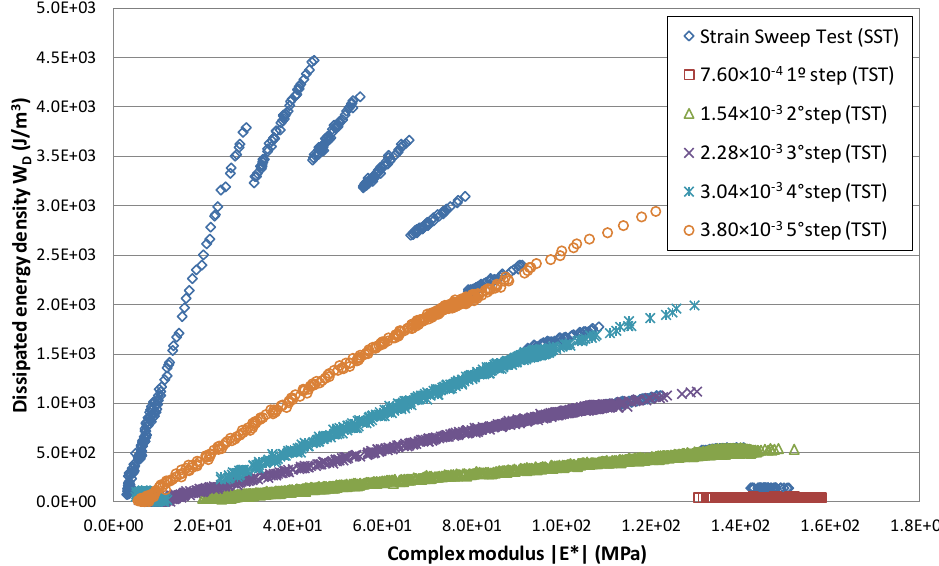
Figure 4. Relationship between the evolution of the modulus and the dissipated energy density in the time and strain sweep tests (60/70 penetration bitumen).